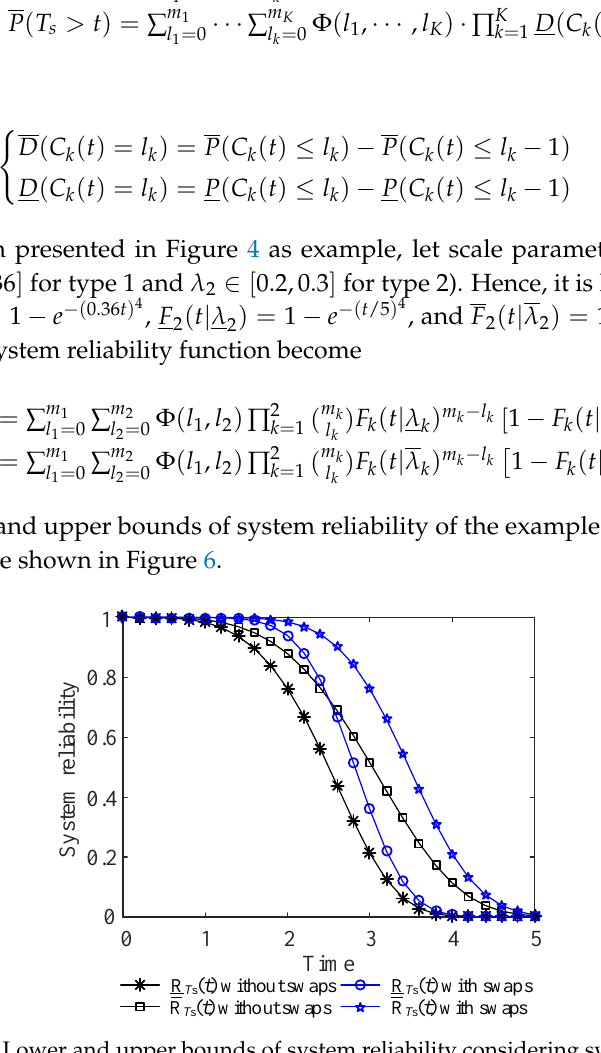
Figure 6. Lower and upper bounds of system reliability considering